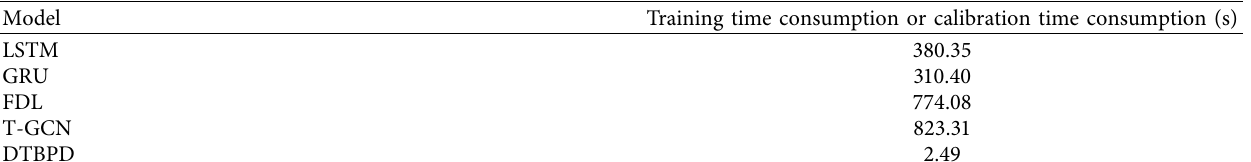
Table 4: Comparison of time consumption between the DTBPD model and DL-based models. Model